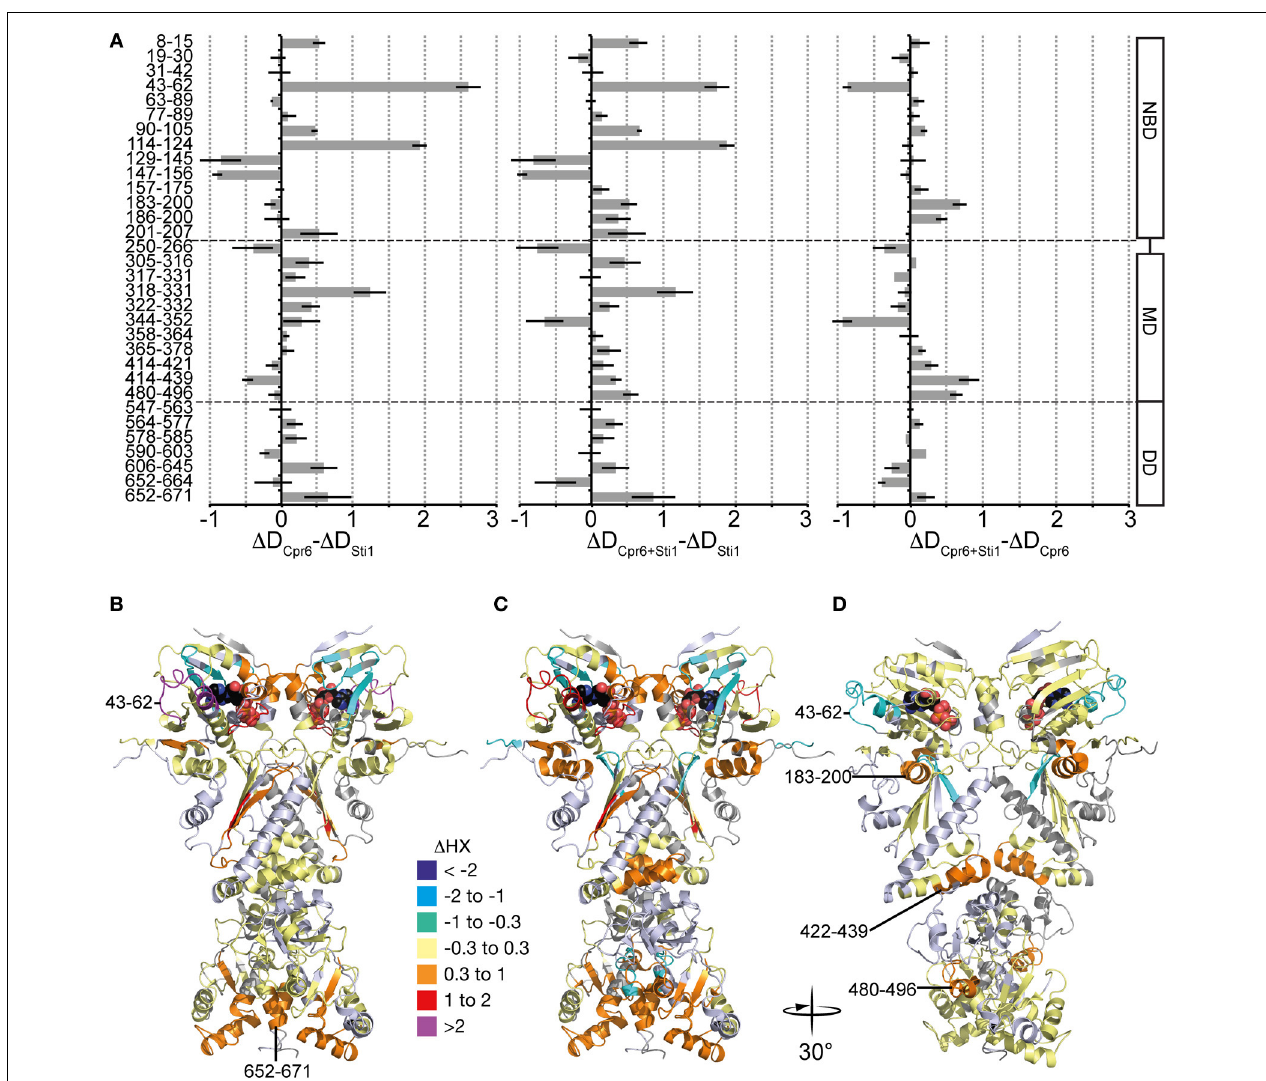
FIGURE 8 | Comparison of Cpr6 and Sti1-induced changes in dynamics of yHsp82. (A) left panel, Difference of Cpr6-induced changes in HX in yHsp82 as compared to Sti1-induced changes [data ( Figure 7A ) -data ( Figure 7C )]; middle panel, Difference in changes in HX of yHsp82 induced by simultaneous presence of Cpr6 and Sti1 as compared to presence of Sti1 alone [data ( Figure 7B ) -data ( Figure 7C )]; right panel,